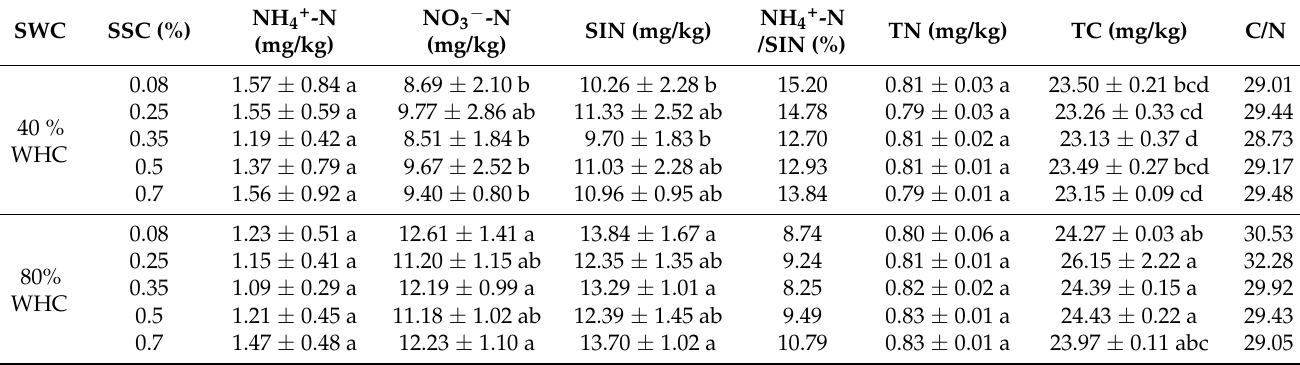
Table 2. Soil NH 4+ -N, NO 3 − -N, SIN, TN, and TC content, and NH 4+ -N/SIN and C/N after